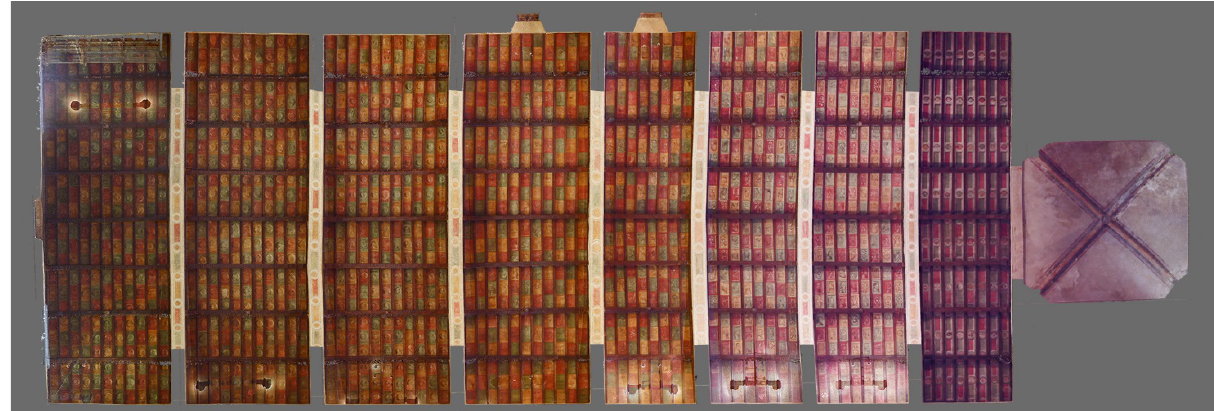
Figure 7. Orthophoto of the ceiling with the painted tiles between the beams and the joints of the roof. Lighting system are still